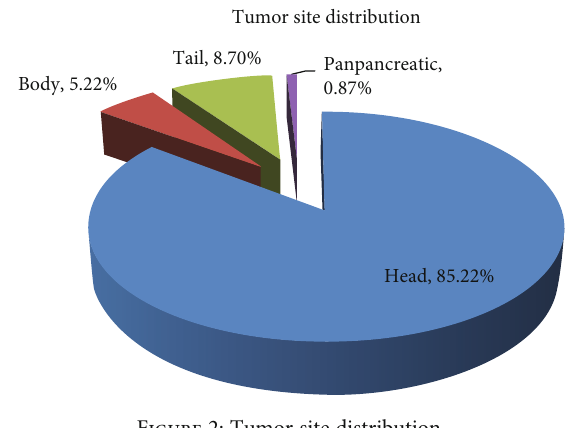
Figure 5: Pancreatic ductal adenocarcinoma, endoluminal necrosis, hematoxylin-eosin staining, × 200.